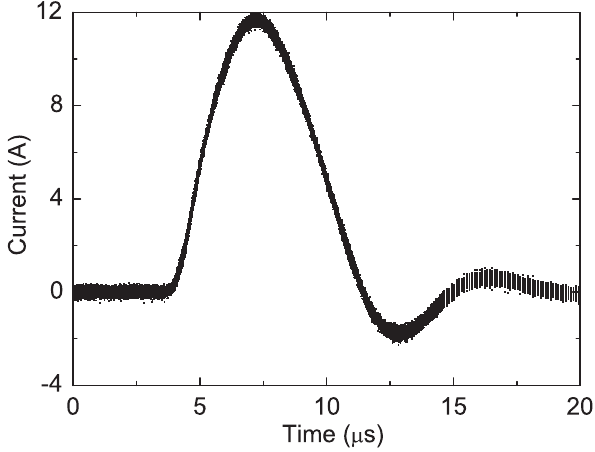
FIG. 7. Measured output current waveform of the fast counterkicker.